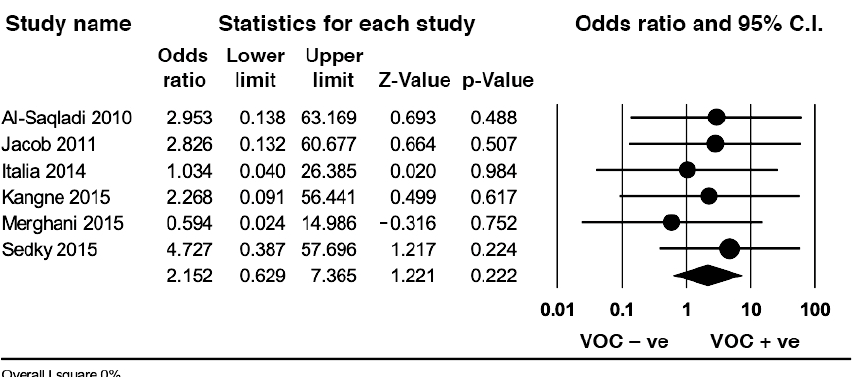
Figure 5. Effect size of the pooled prevalence of the methylenetetrahydrofolate reductase TT in sickle cell disease out and in vaso-occlusive crisis.